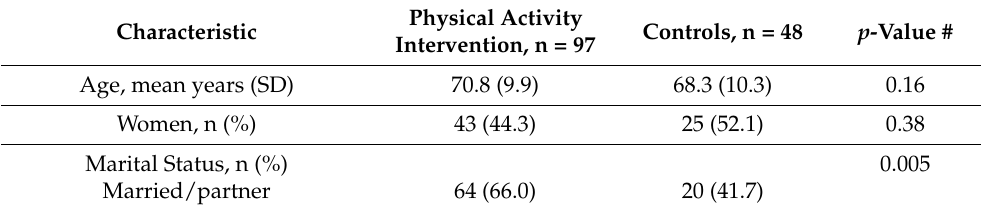
Table 1. Baseline Characteristics of Older Stroke Survivors According to